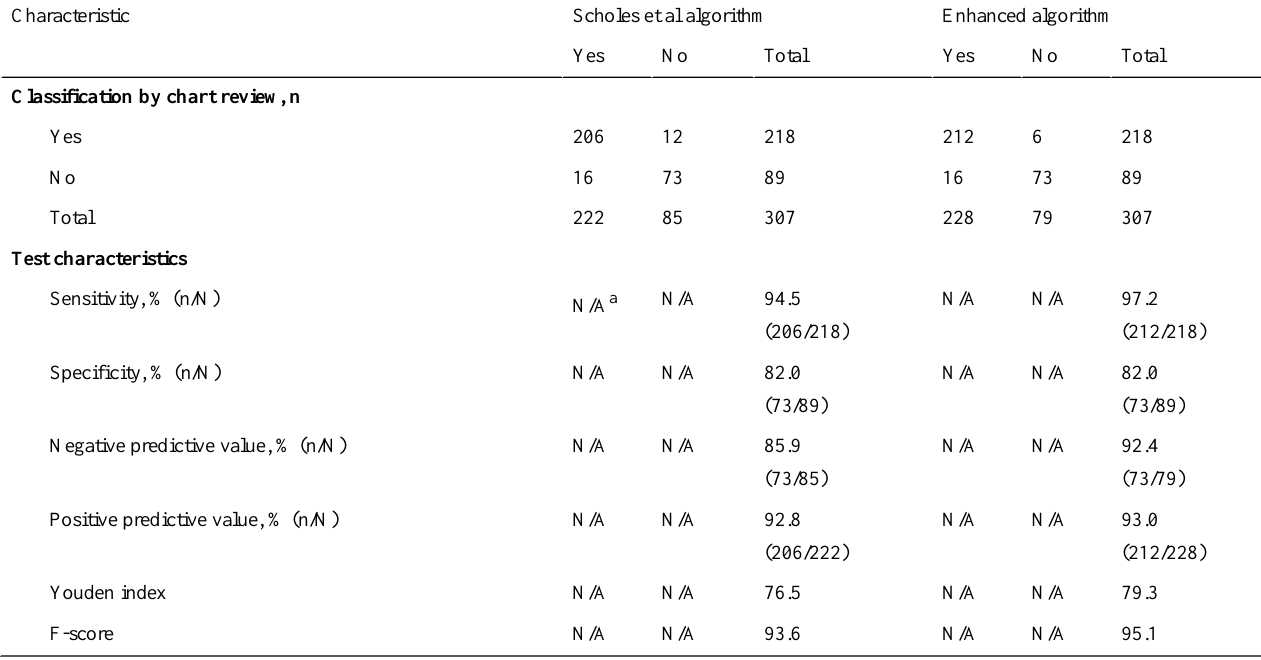
Table 4. Sensitivity analysis of ectopic pregnancy ascertainment performance of the Scholes et al [4] and enhanced ectopic pregnancy algorithms on a 2009-2014 ICD-9–only subset.